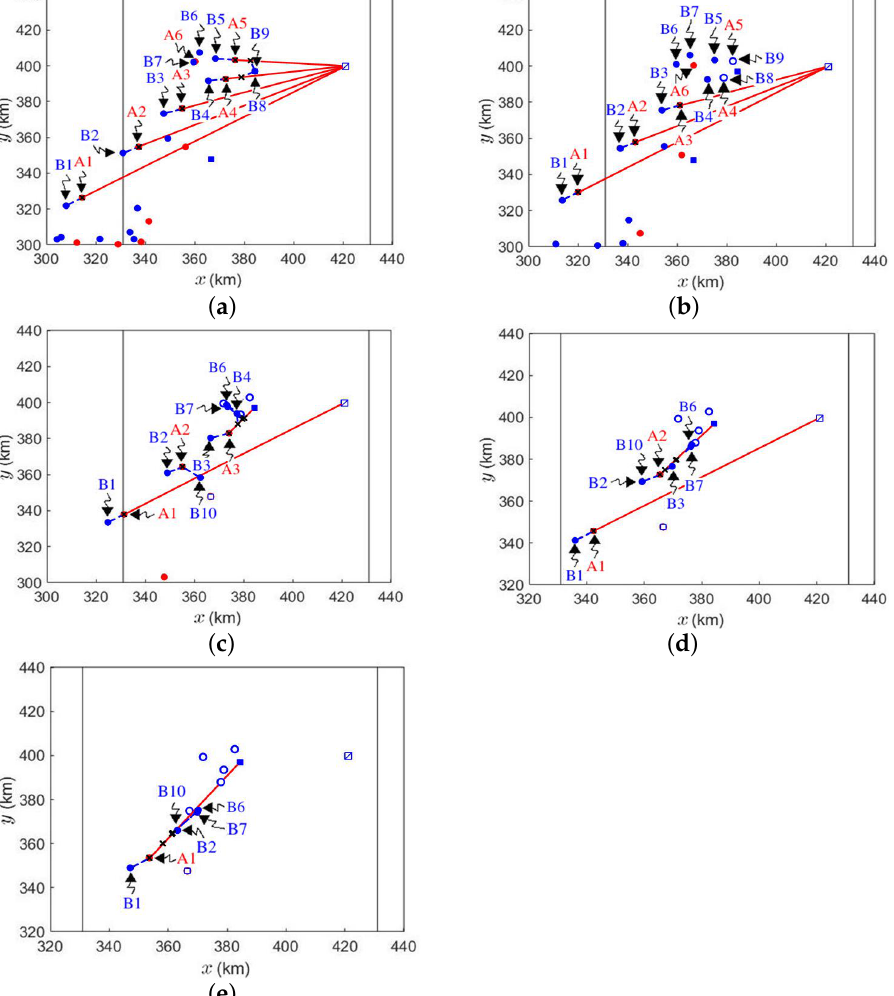
Figure 13. Scenario in case 2 on ζ 1 , against slant formation, ( a ) t = 580 s; ( b ) t = 600 s; ( c ) t = 640 s; ( d ) t = 680 s; ( e ) t = 720